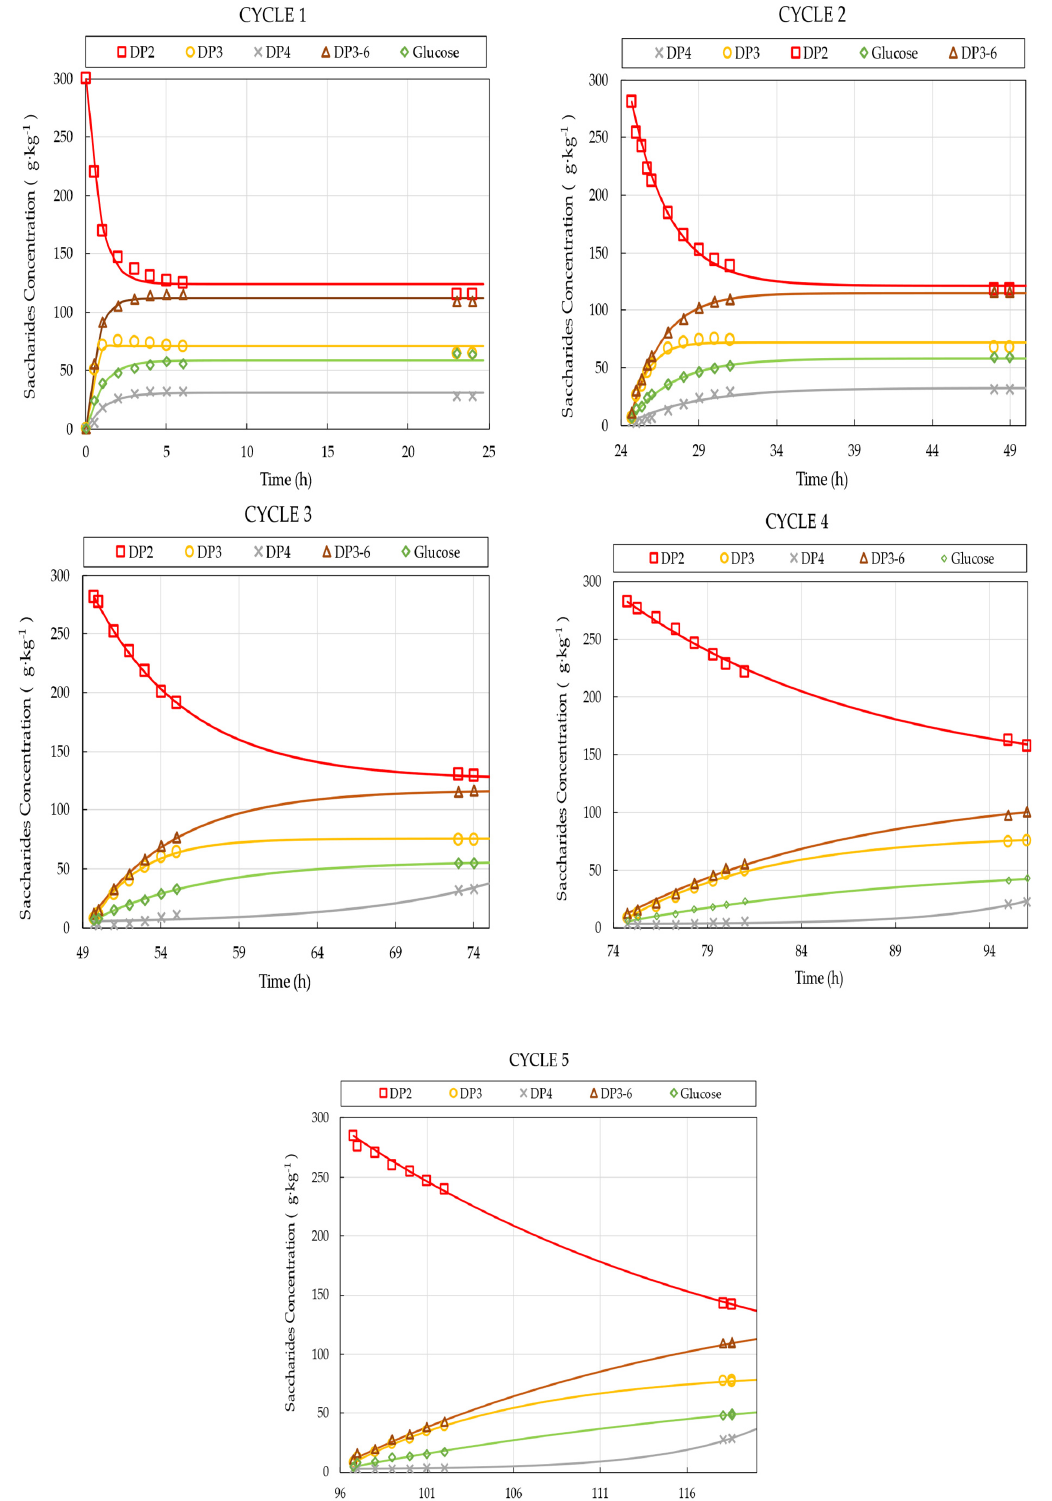
Figure 4. Saccharides composition in the reactor as function of operational time for 5 consecutive cycles. Symbols represent measured values; solid lines are model predictions evaluated by using Equation (7). Operational conditions: 300 g·kg − 1 initial lactose concentration, 8307 U·kg − 1 initial enzyme load, pH 6.0, 50 °C .